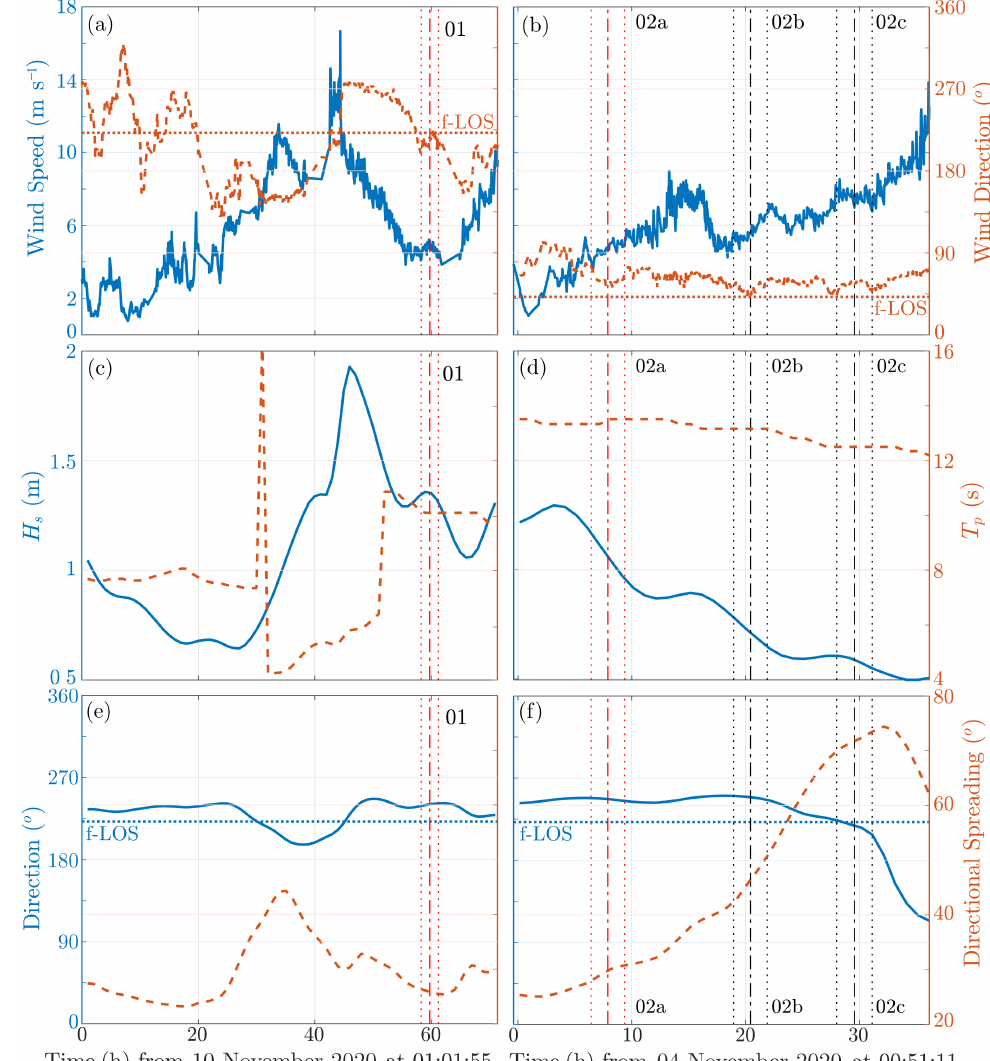
Figure 3. Evolution of wind and sea-state quantities around Cases 01 (left) and 02[a–c] (right). ( a , b ) Horizontal Wind Speed (WS) and Wind Direction (WD). Wave model (WWIII) hind-cast: ( c , d ) the significant wave height ( H s ) and peak period ( T p ); ( e , f ) the wave peak direction ( α w ) and directional spreading ( β w ). Horizontal lines in ( a , b , e , f ) denote the sLiDAR fLOS-aligned directions φ L and φ L − 180°. Vertical lines denote the initial, middle and final moments of the selected